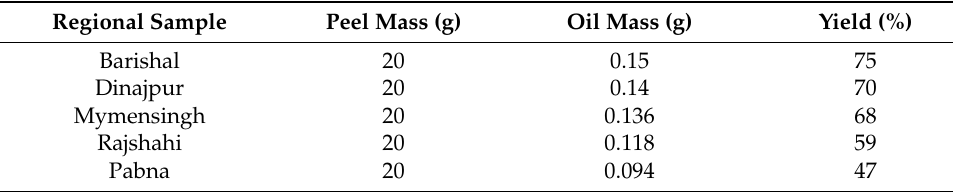
Table 1. Regional samples, oil mass, and its product